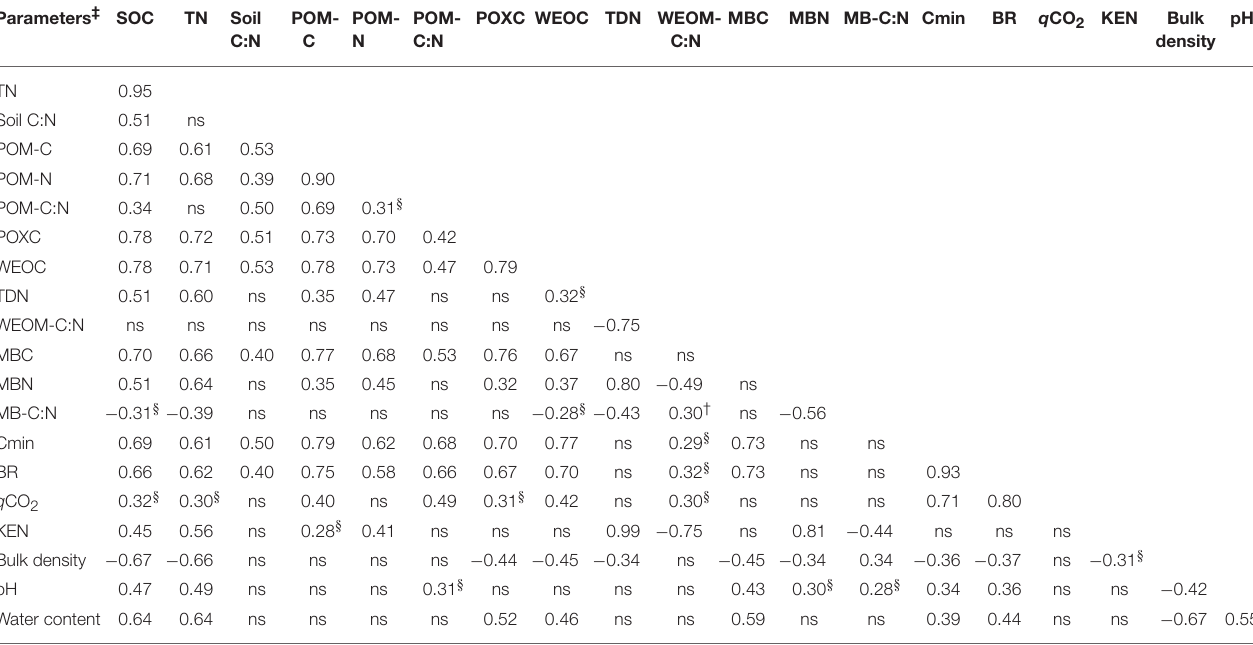
TABLE 5 | Pearson correlation coefficients ( r ) † of soil parameters across the